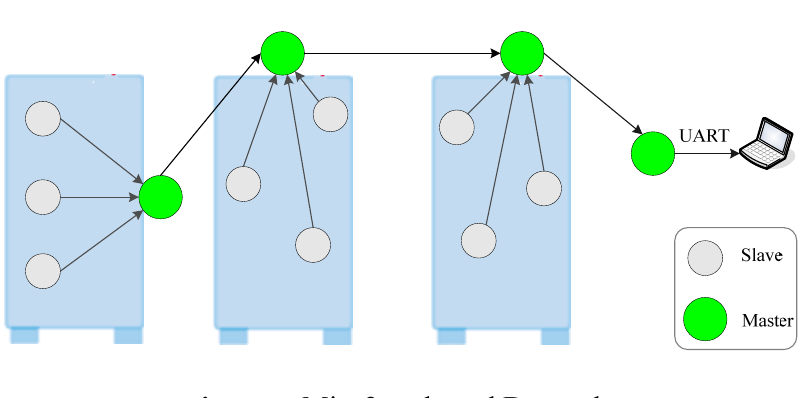
Figure 2. Mica2 node and Dot